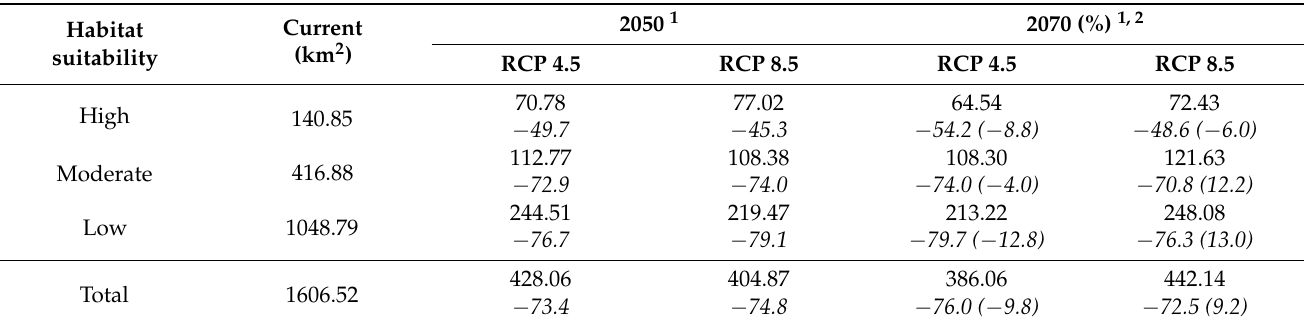
Table 3. Changes in habitat suitability of X. loweryi in the study area considering human disturbance factors by 2050 and